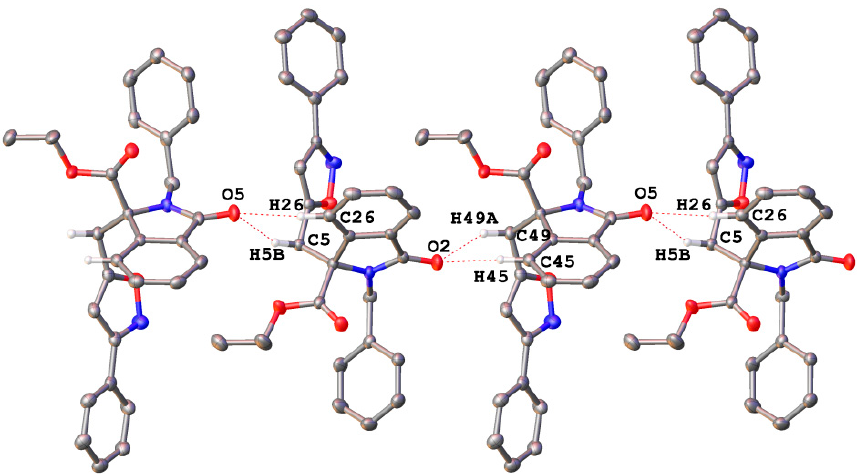
Figure 4. 1D Chain structure of 4a build through weak O···H–C hydrogen bonds.